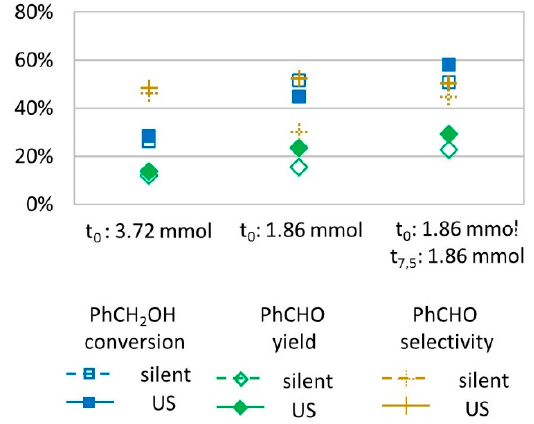
Figure 2. Oxidation of PhCH 2 OH as a function of the H 2 O 2 introduction mode in silent condition and under US irradiation (20 kHz). Reaction conditions: 571 mM PhCH 2 OH, 1 molar eq. H 2 O 2 ; 1% molar eq. FeSO 4, 5.61 mL H 2 O, 70 °C, 15 min); silent conditions: Argon bubbling; US conditions: 20 kHz, P acous = 47.9 W L − 1 h − 1 , 13 mm probe.